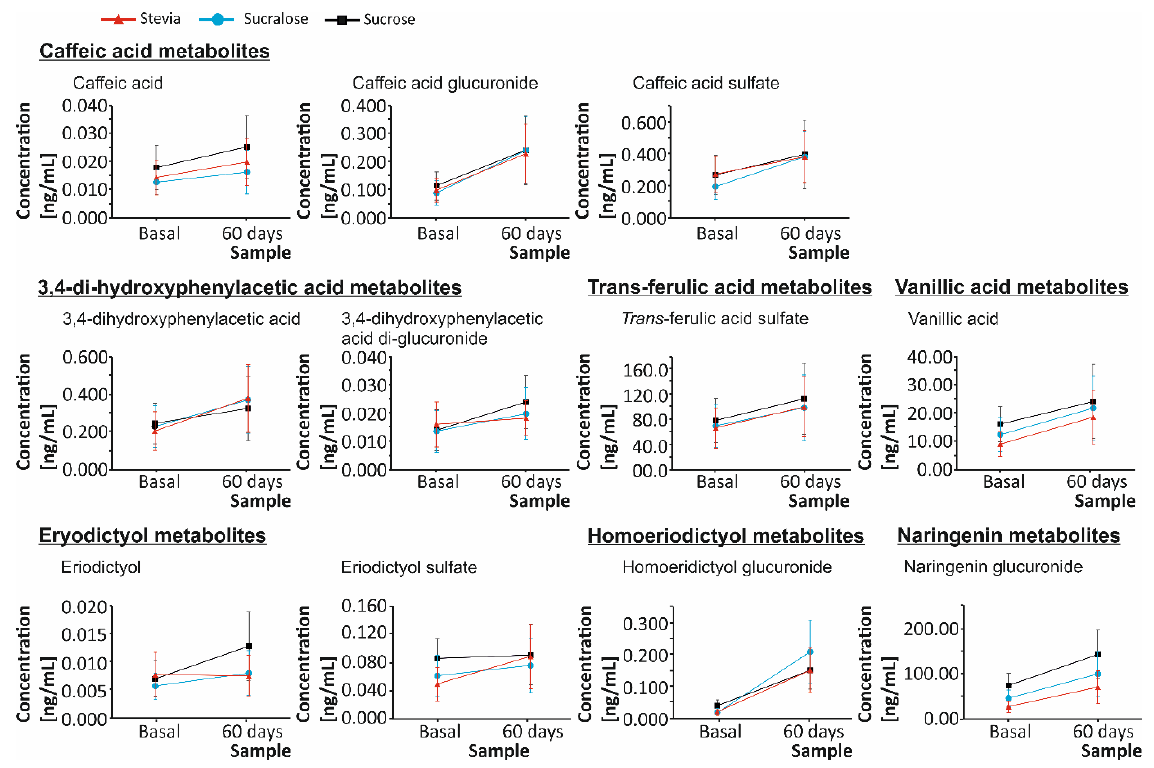
Figure 1. Content of single anthocyanins and flavanones metabolites (caffeic acid, caffeic acid glucuronide, caffeic acid sulfate, 3,4-di-hydroxyphenylacetic acid, 3,4-di-hydroxyphenylacetic acid di-glucuronide, eriodictyol, eriodictyol sulfate, homoeriodictyol glucuronide, naringenin glucuronide, trans-ferulic acid sulfate, and vanillic acid) in basal urine and 60 days urine of healthy volunteers after daily ingestion of 330 mL of maqui-citrus drinks developed using as sweeteners stevia (red ∆ ), sucralose (blue O), and sucrose (black □ ).